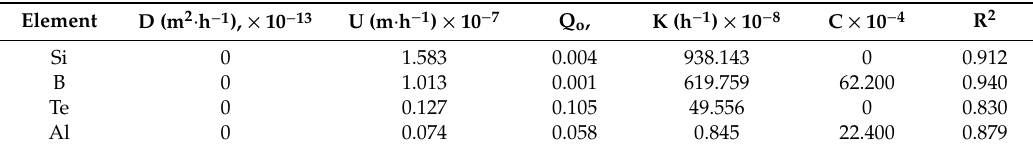
Figure 6. Preliminary investigation of structural element leaching mechanisms for samples: ( a ) ABS-waste (17); ( b ) MABS-waste (20); ( c ) ABS-waste (25). Table 9. Nonlinear curve fitting parameters of the cumulative leach fraction of metalloid and post-transition elements: ABS-Waste (17).